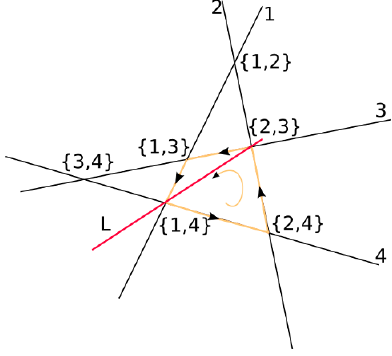
Figure 5 . A triangulation of the quadrilateral corresponding to the list l = (1 ; 4 ; 2 ; 3) that does not introduce any spurious